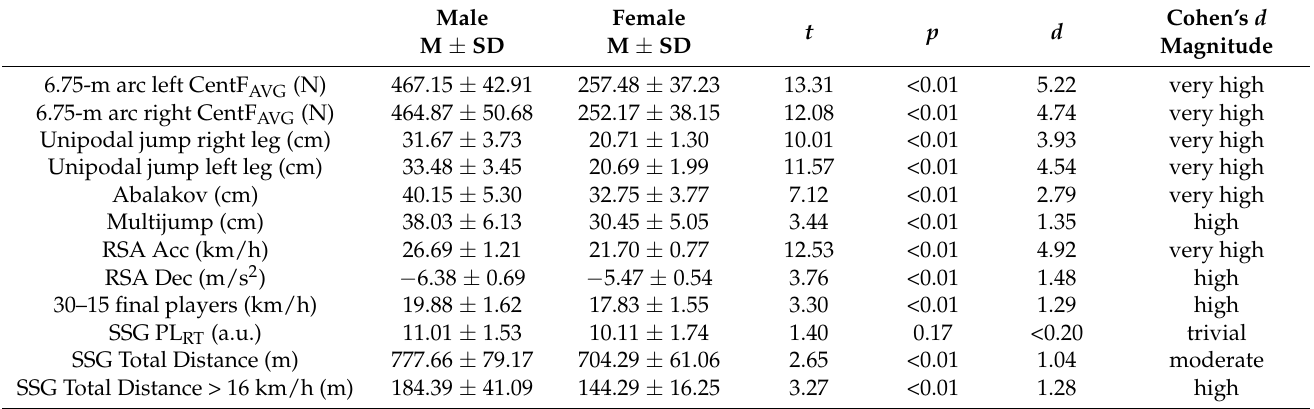
Table 1. Descriptive and inferential analysis of sex-related differences in physical fitness profile of semiprofessional basketball players.